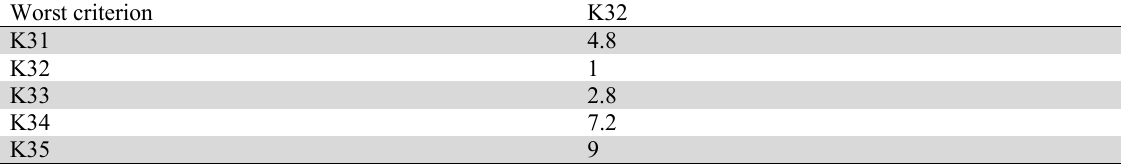
Science and technology sub-criteria OW Vector Worst